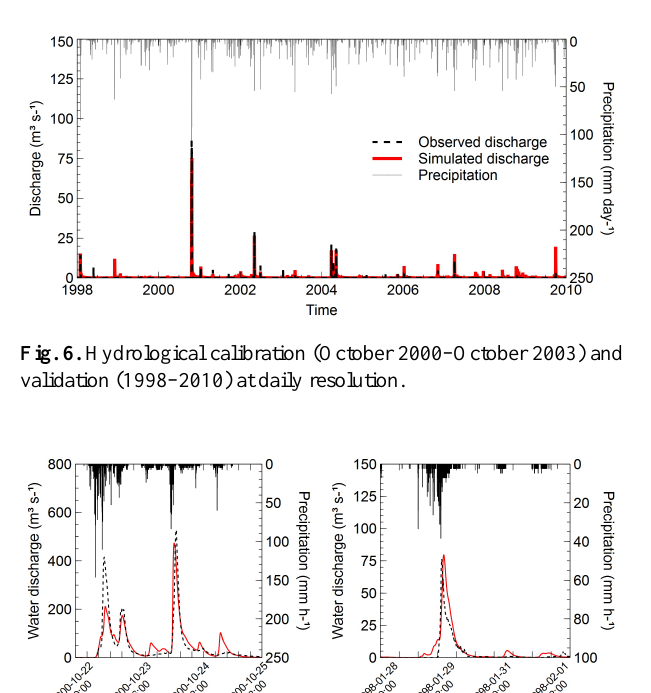
Fig. 8. Upper left: geomorphological sketch with location of the dam structure and trenches BG-1 and BG-2. Bottom left: longitu- dinal profile across the dam infill and distribution of the two main depositional bodies, i.e. gravel bar and fine deposits (sand and silt). Right: synthetic stratigraphical profiles from trenches BG-1 and